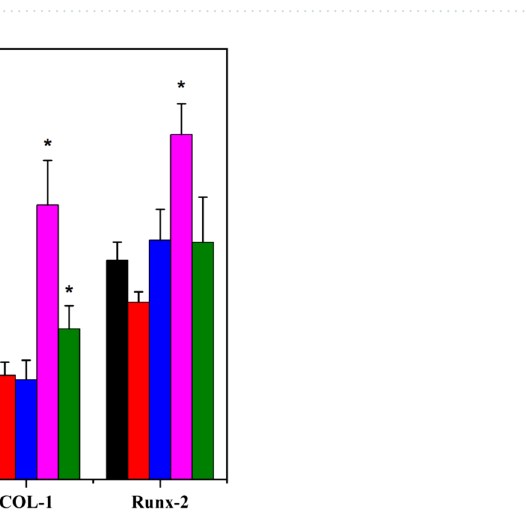
Figure 9. BMSCs cultured on MSP and LMSP-1–4 microsphere-based scaffolds for 21 days were stained with Sirius red staining Kit to evaluate the collagen secreted from cells.